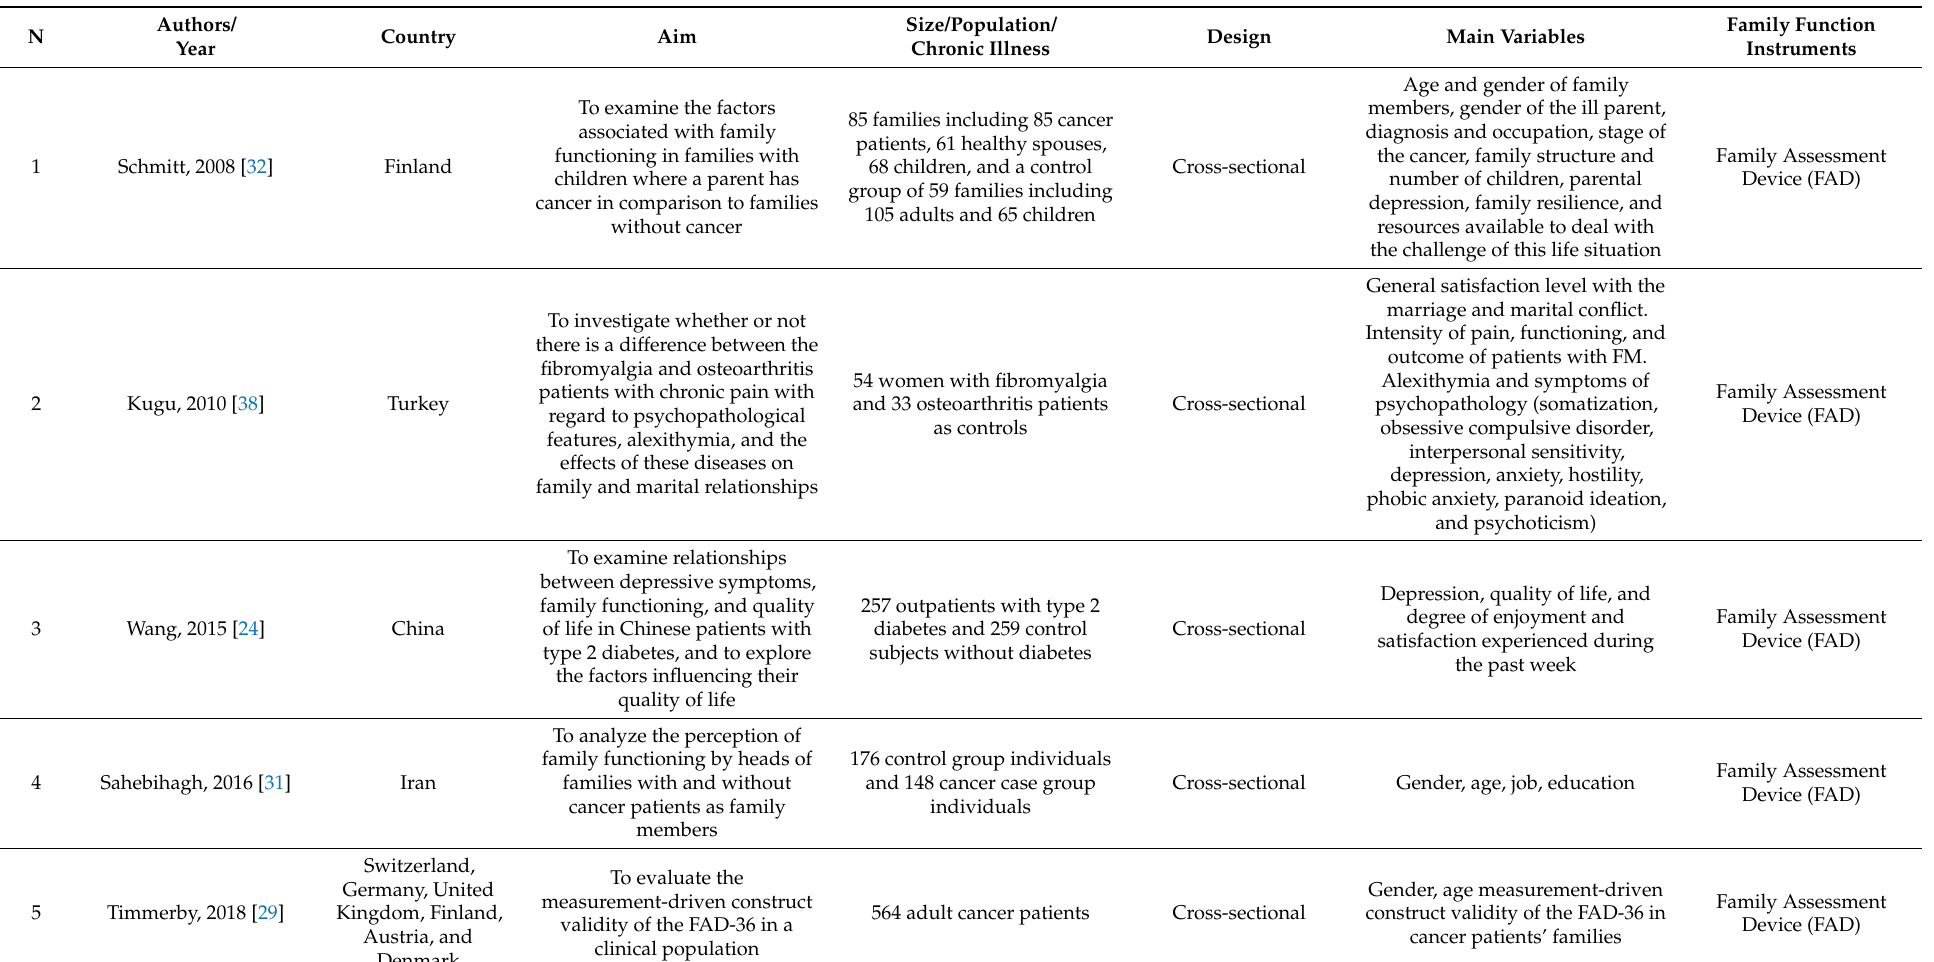
Table 1. Articles included in the